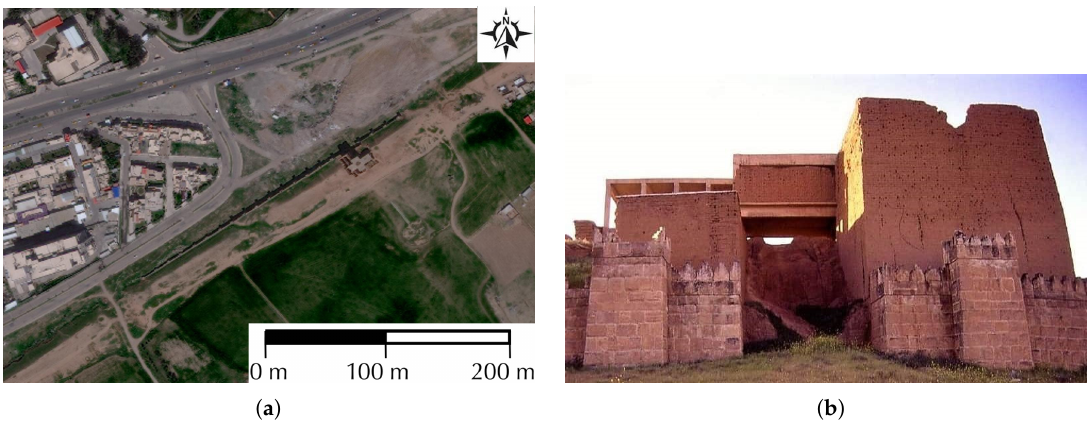
Figure 26. Overview of Adad Gate before the destruction: ( a ) GeoEye-1, 1 April 2016 c (cid:13) DigitalGlobe; and ( b ) ground view (before 2013)